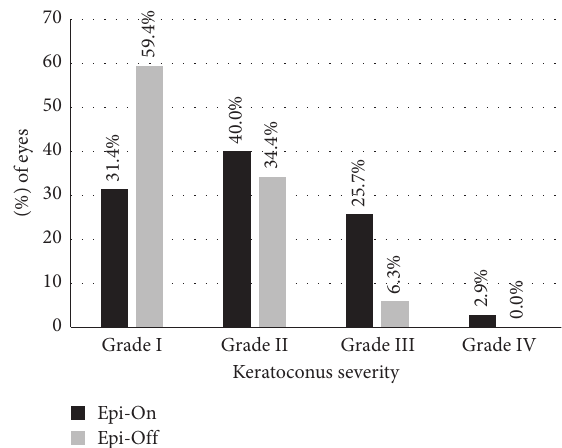
Figure 1: Distribution of keratoconus severity according to the Amsler–Krumeich grading system in the epi-on and epi-off